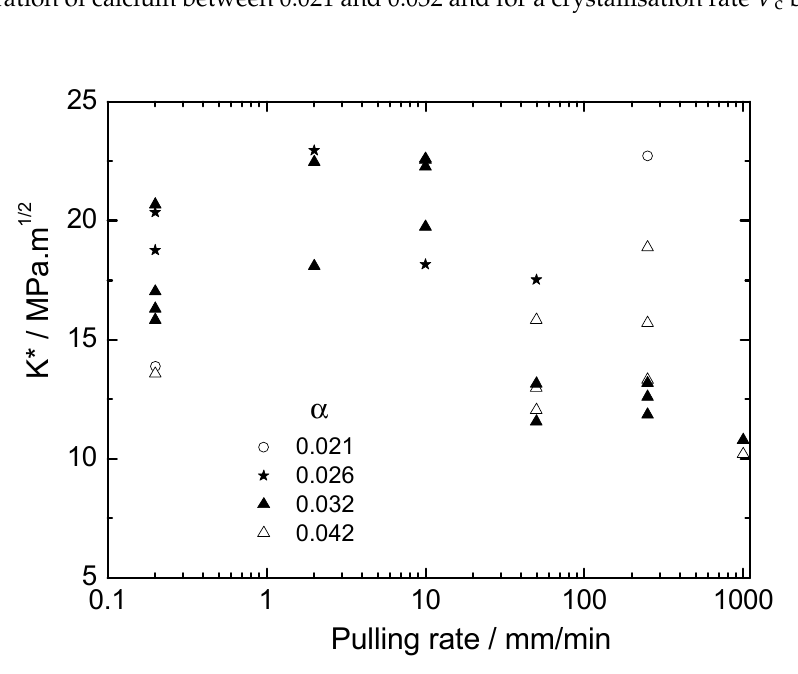
Figure 6. Critical stress intensity factor of oxide-fibre/molybdenum-matrix composites versus pulling rate.